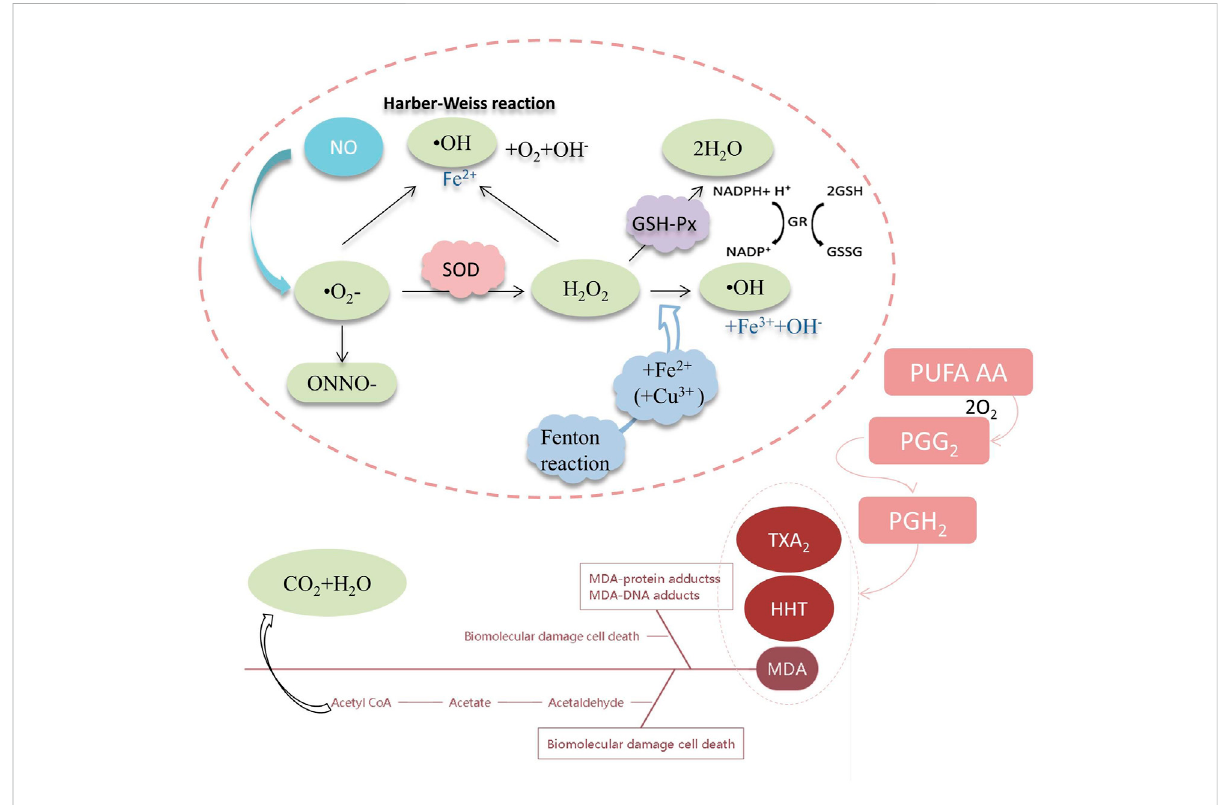
FIGURE 6 MDA, SOD and GSH-Px are involved in the oxidation